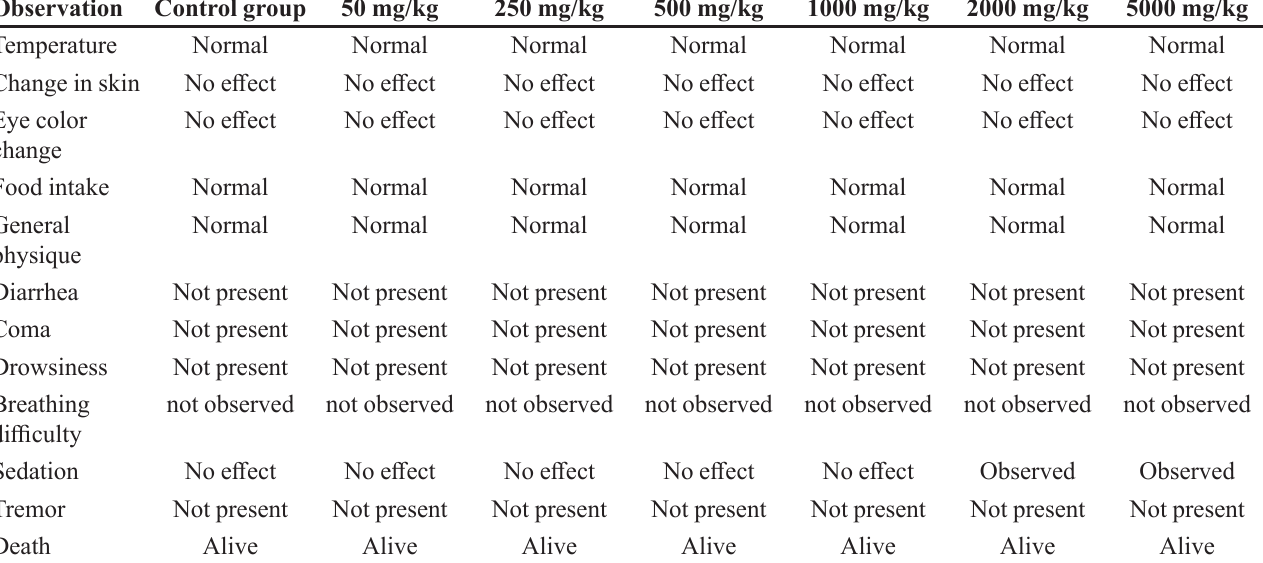
TABLE I - Behavioral responses and general appearance of rat treated with single dose of AERI in acute toxicity study Observation